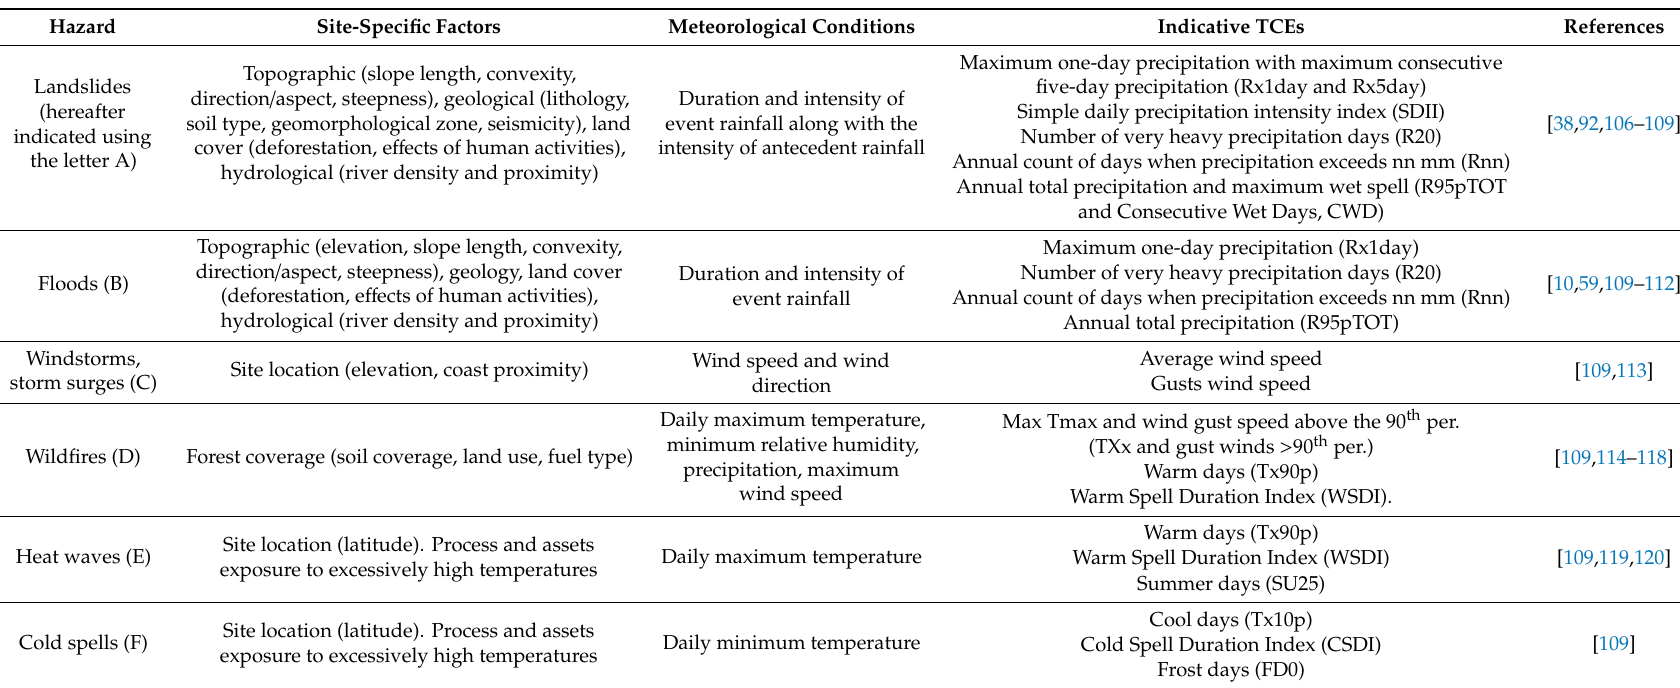
Table 2. Site-specific factors relating to hazards under investigation. TCEs: Triggering Climatic